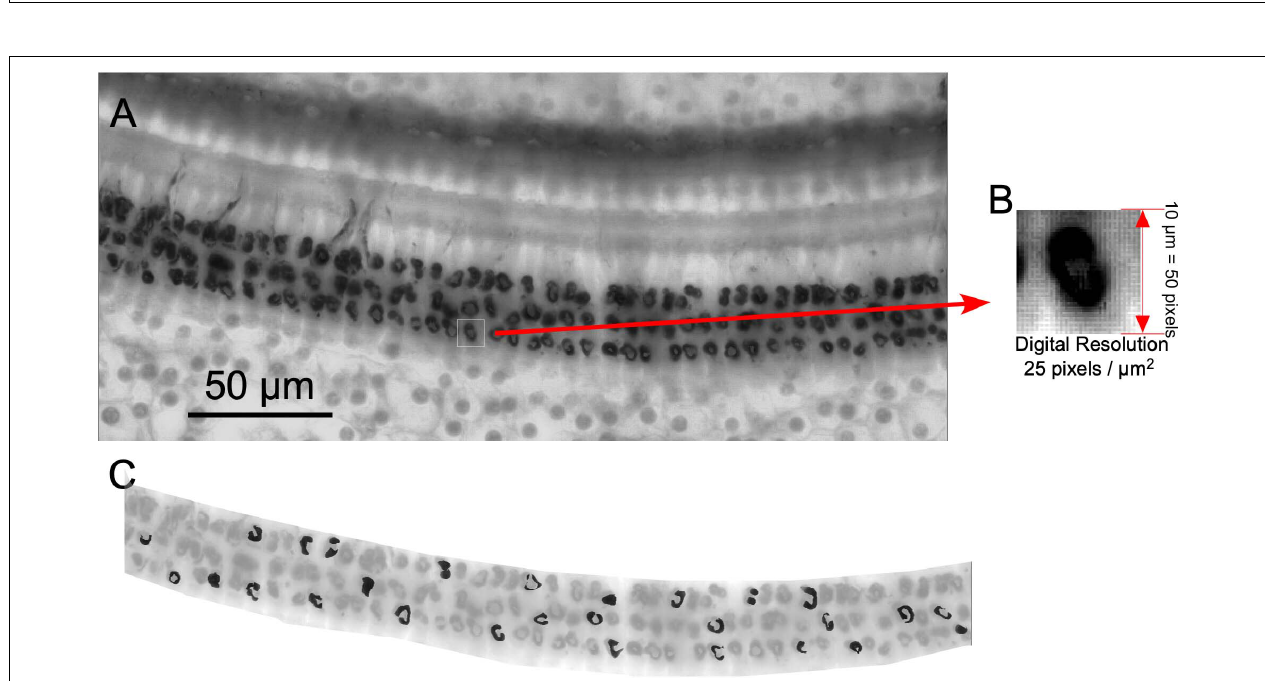
FIGURE 3 | Methodology used for densitometric analysis of immunoreactive buttons. (A) Example of a × 40 deep focus picture. (B) Digital resolution. (C) Thirty terminals per frame (highlighted in black) were manually taken by using freehand tool (ImageJ software).